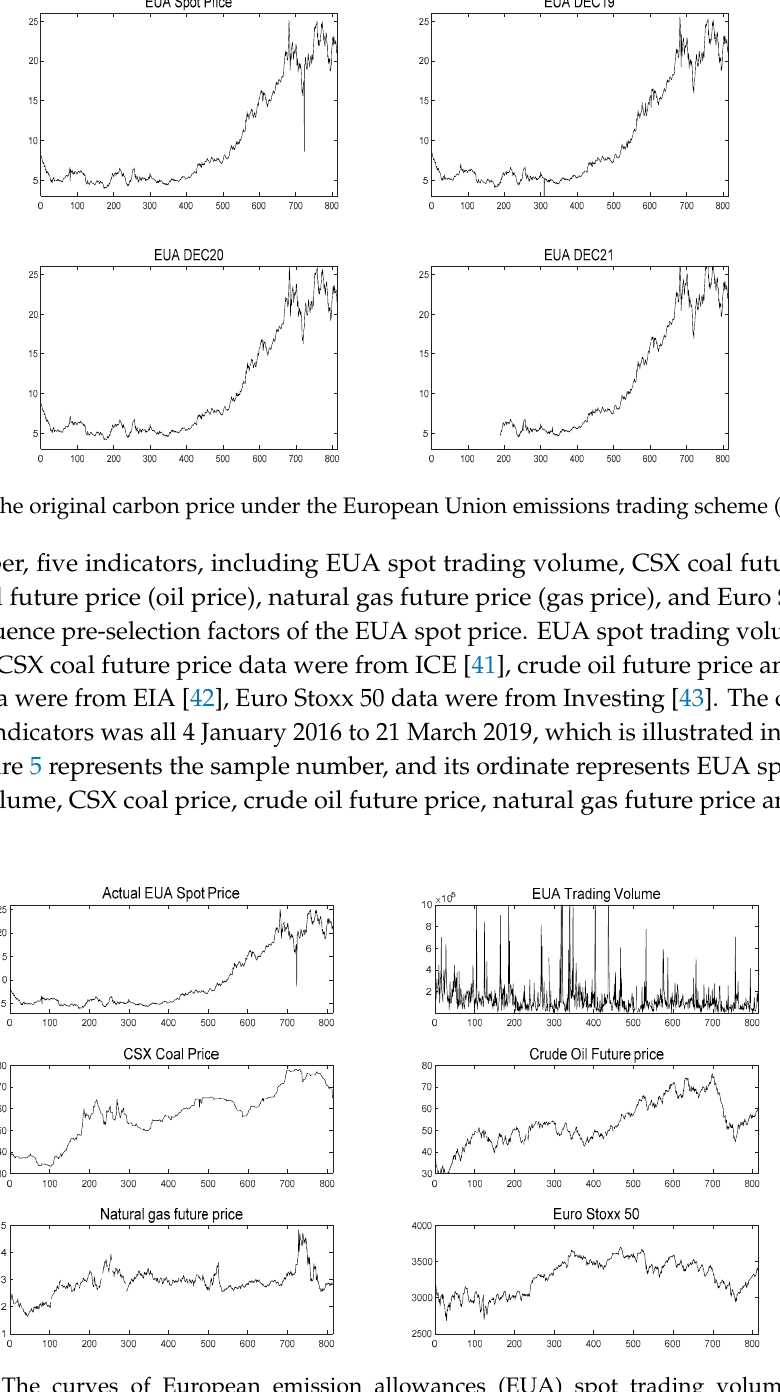
Figure 5. The curves of European emission allowances (EUA) spot trading volume and its external factors.